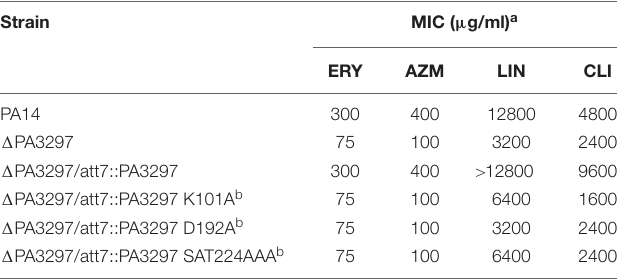
TABLE 3 | Bacterial susceptibilities to macrolides and lincosamides. Strain